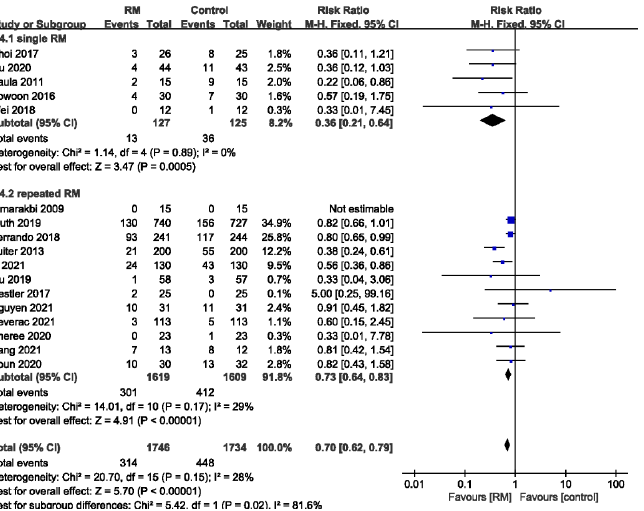
Figure 6. Forest plot for subgroup analysis of the incidence of PPCs between RM and control groups. Grouped by the number of RM: single RM, repeated RM [16 – 32].